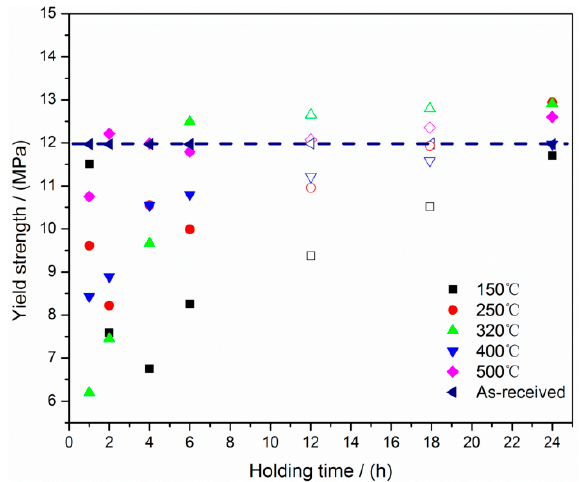
Figure 8. Compressive yield strength of foams under different conditions.